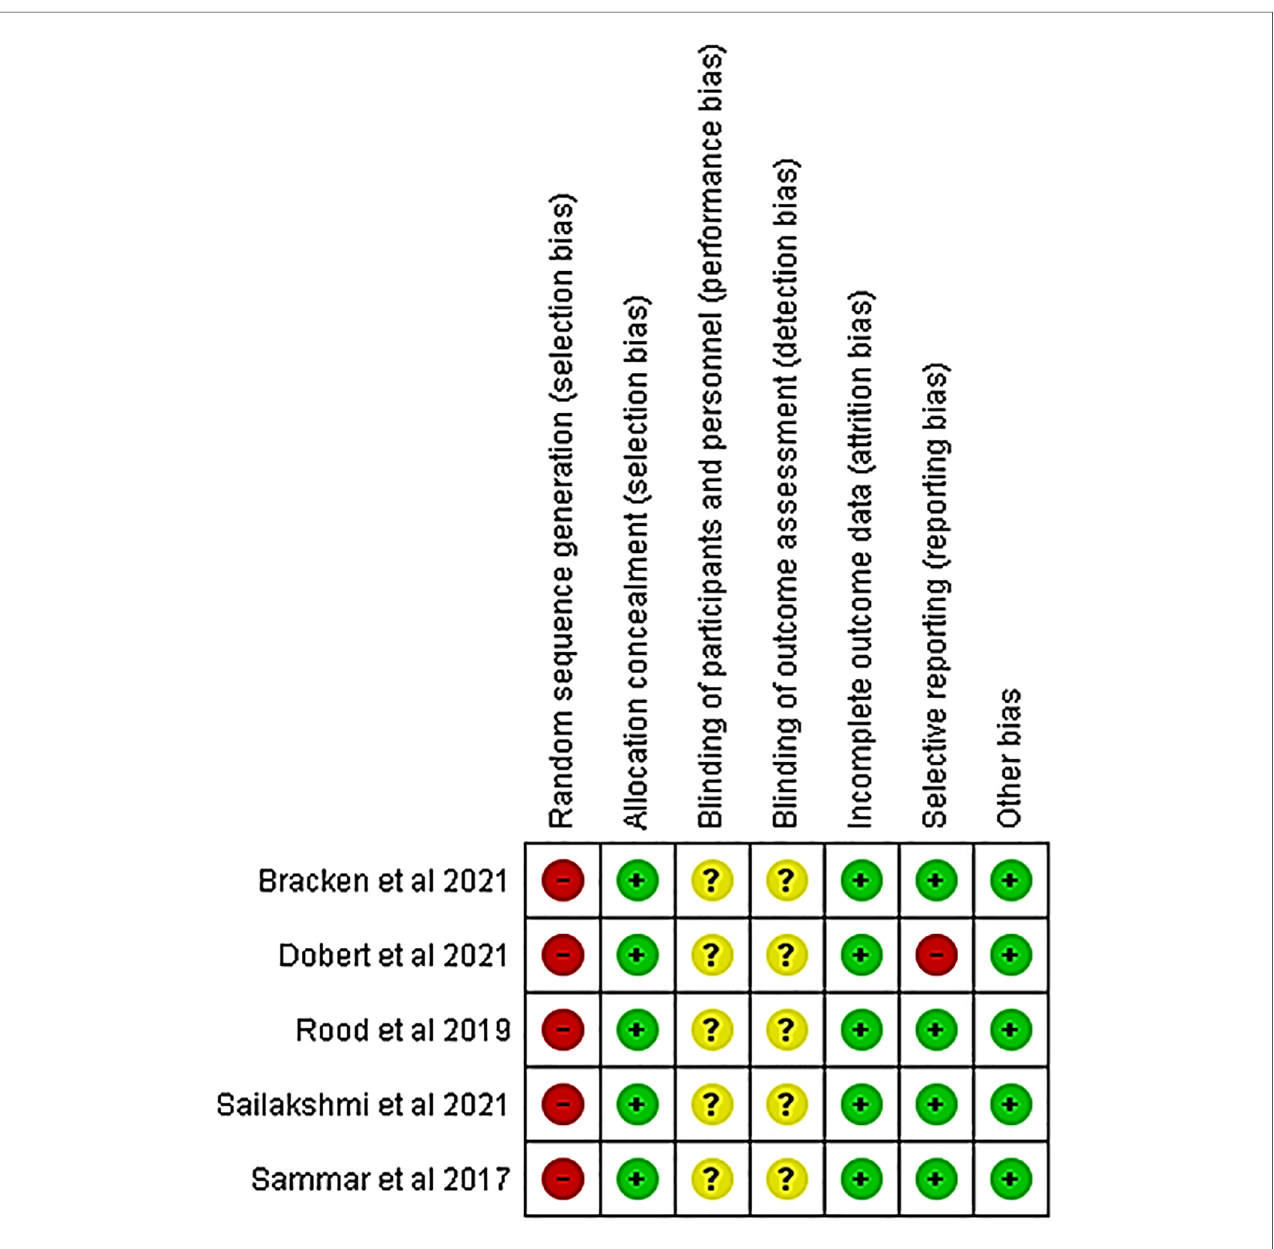
FIGURE 5 Risk of bias summary review authors' judgments about each risk of bias item for each included